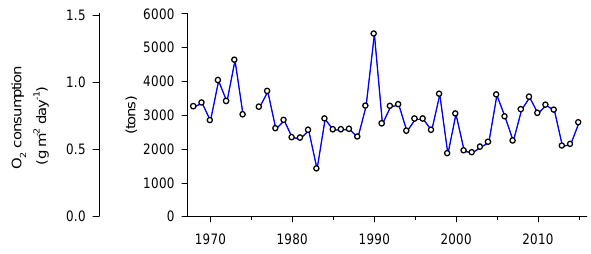
Figure 11. July–October oxygen consumption in the Stockholm in- ner archipelago deep water in 1968–2015, calculated with the mean